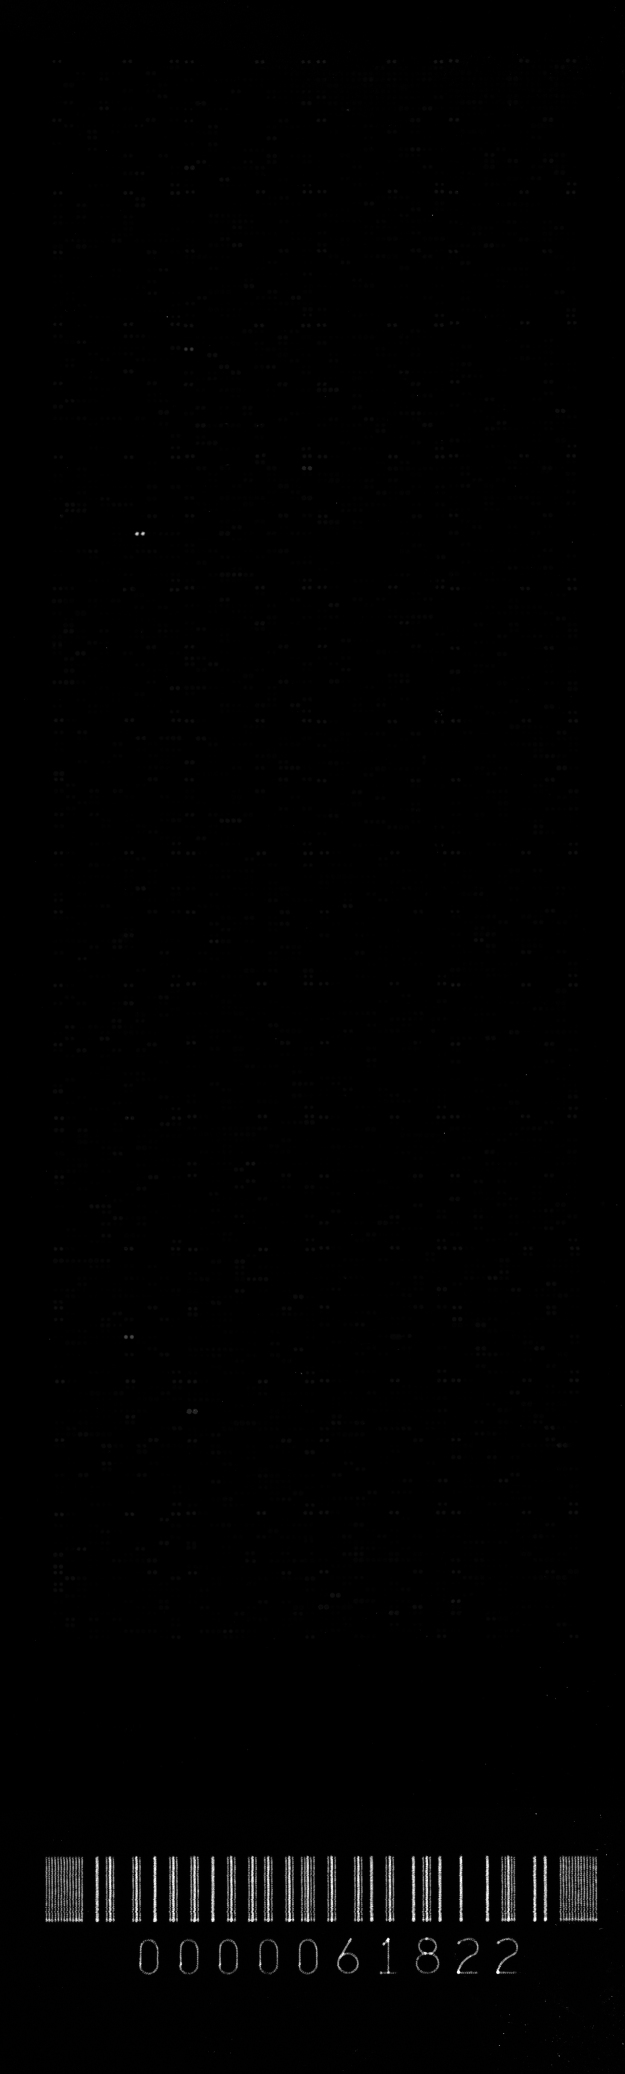
High Resolution Array Image. Negative control.